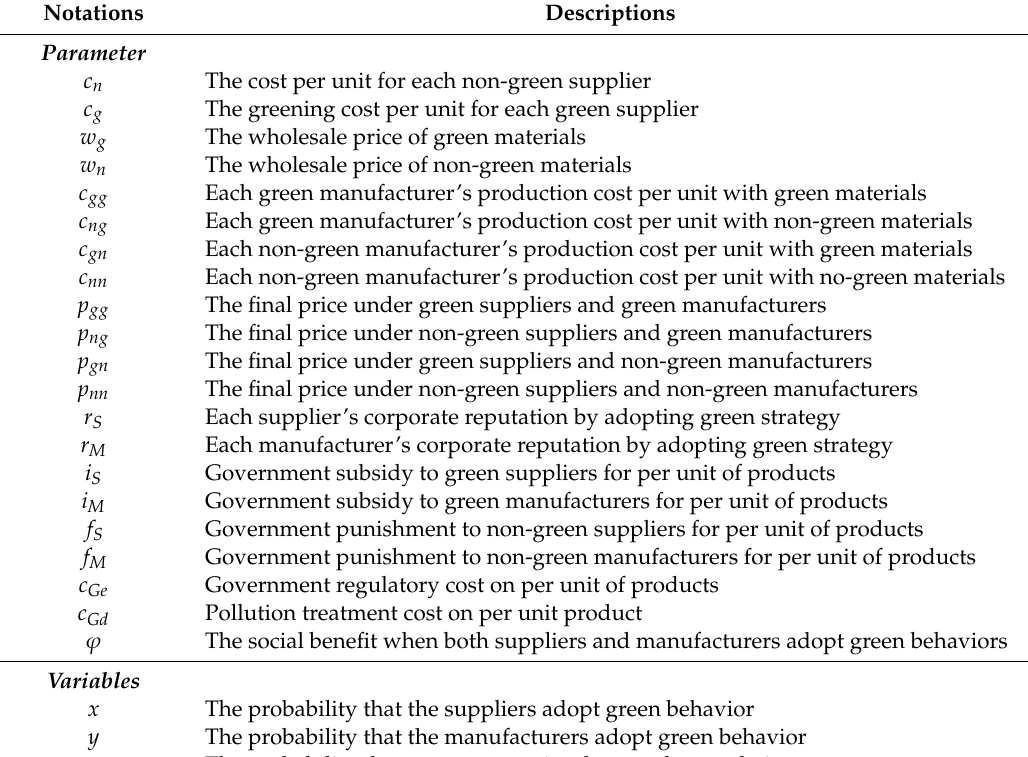
Table 1. Parameters and